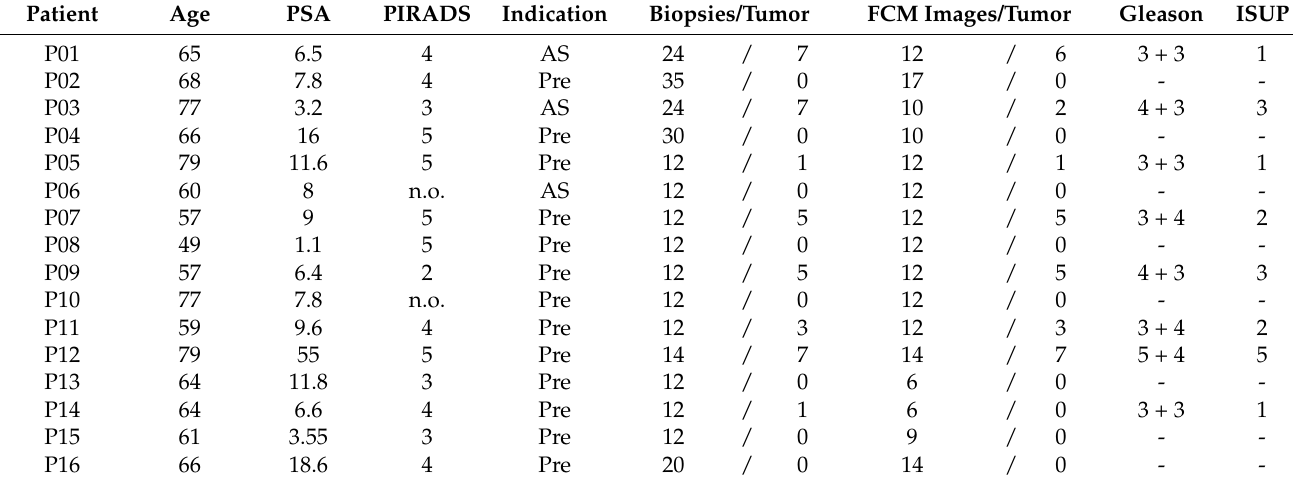
Table 1. Clinical data, number of biopsies taken and examined in FCM, tumor